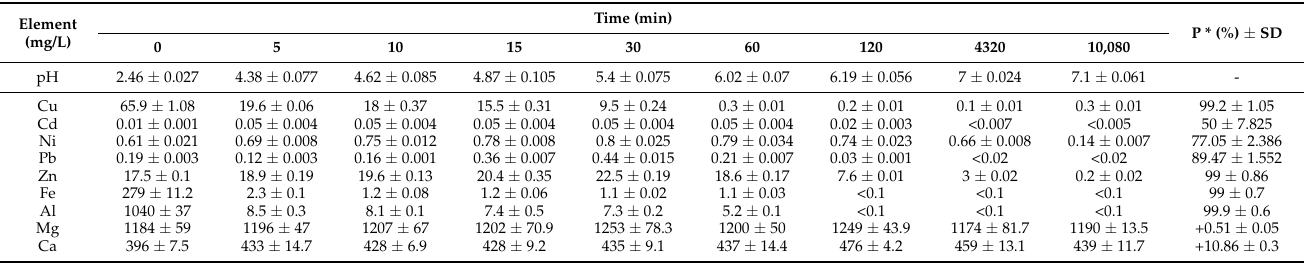
Table 3. Concentrations of metals as a function of time during the neutralization process of acid mine water with EF fly ash.